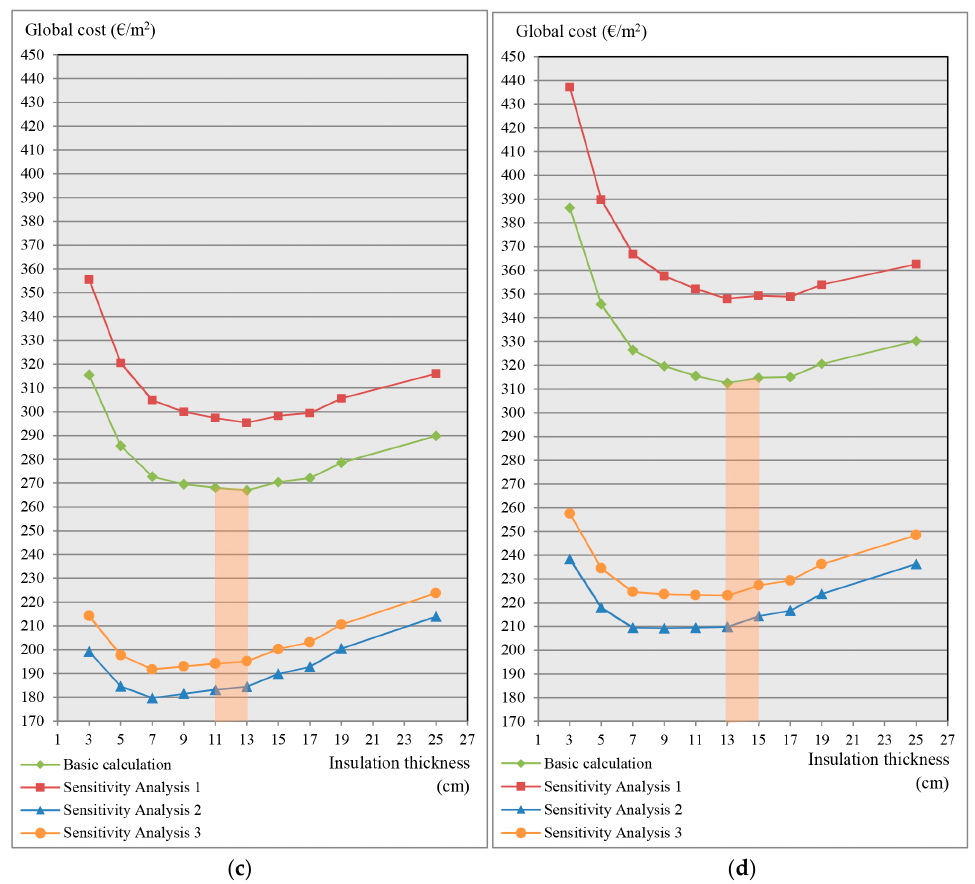
Figure A5. Results of the financial calculation presented graphically for ( a ) Heraklion (climate zone A); ( b ) Athens (climate zone B); ( c ) Thessaloniki (climate zone C) and ( d ) Kastoria (climate zone D).